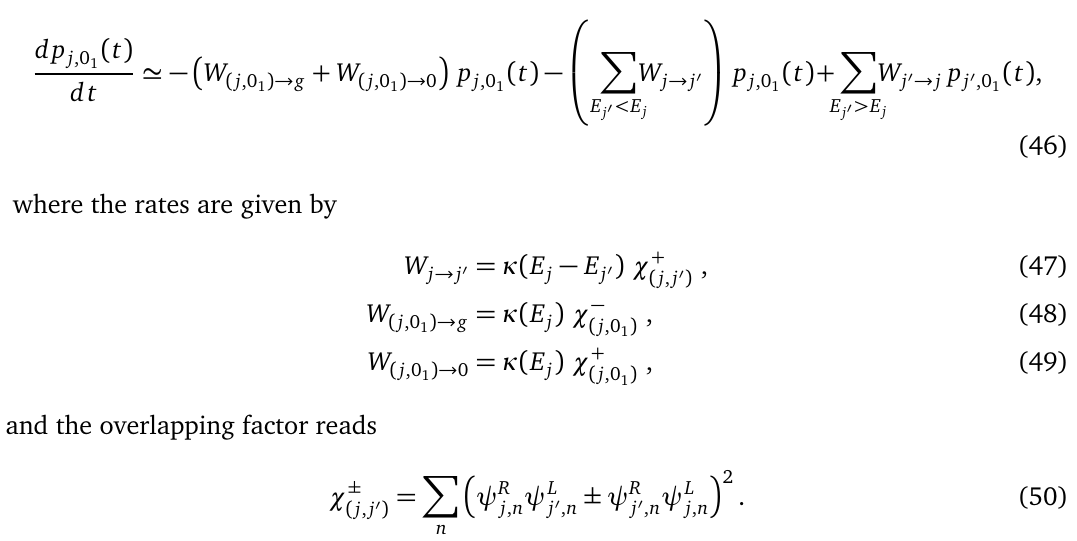
〉 = γ † γ † | GS 〉 to one of the even ground states, | GS 〉 1 3 0 1 < E ). (b) The populations for the j 3 = 4 J ( 1 ) = 8 B x x